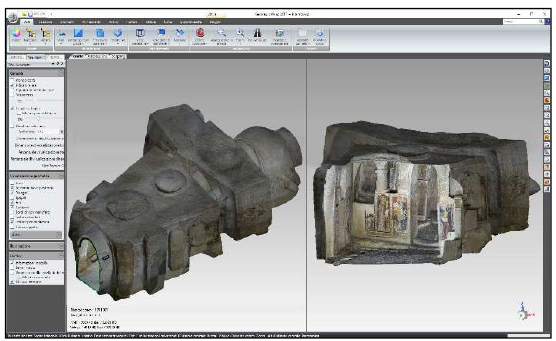
Figure 2: Sw Geomagic Wrap. Mesh